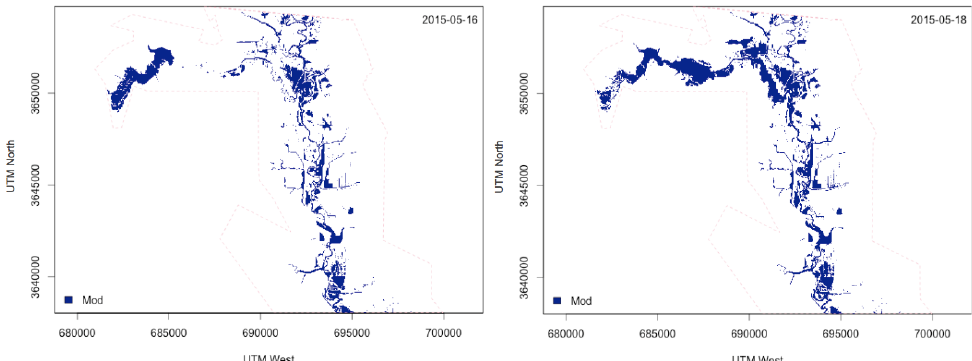
Figure 7. Water surfaces simulated from HEC-RAS for 16 May and 18 May are shown. Water can be seen propagating towards the center of the domain over a two-day period as water is being released from the nearby